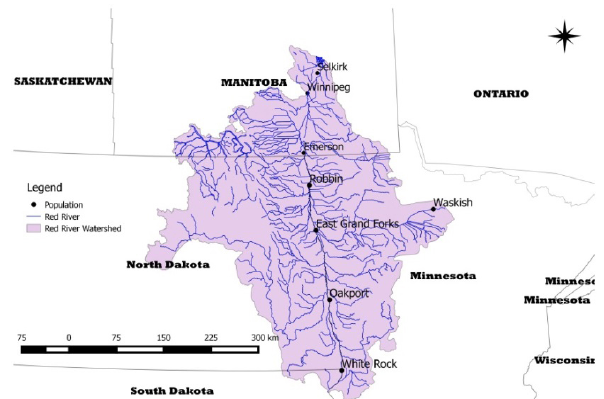
Figure 1. Red River Basin.